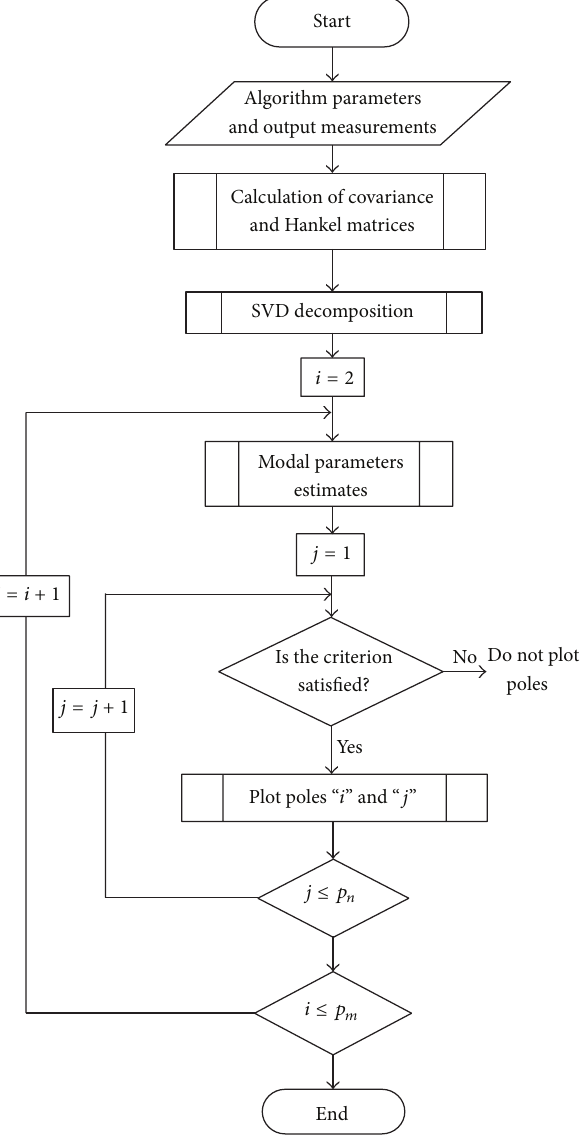
Figure 1: Flow chart, stabilization diagram implementation.